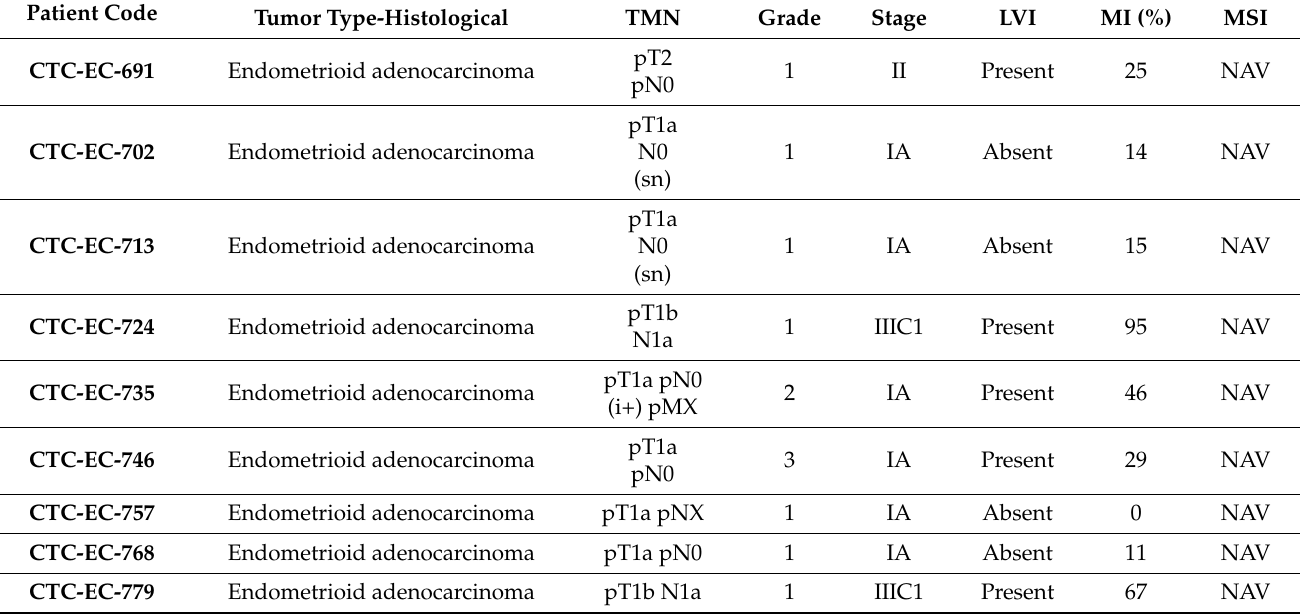
Table 2. Pathology parameters of organ type (endometrial, ovarian, lung, prostate, liver, and esophageal) tumors used for the study (LVI = Lymphovascular Invasion; MI = Myometrial In- vasion; MSI = Microsatellite Instability; NA = Not Applicable; ND = Not Determined; NAV = Not